Question: Condense the content of this figure into a single sentence.
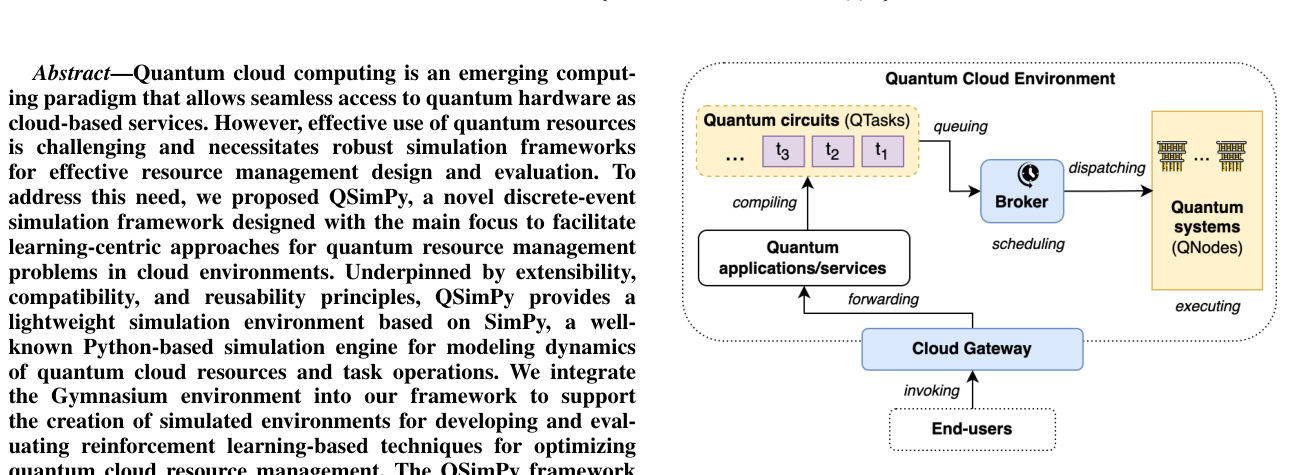
Answer: A high-level view of quantum cloud computing environments and a sample procedure from user invocation to quantum task execution.